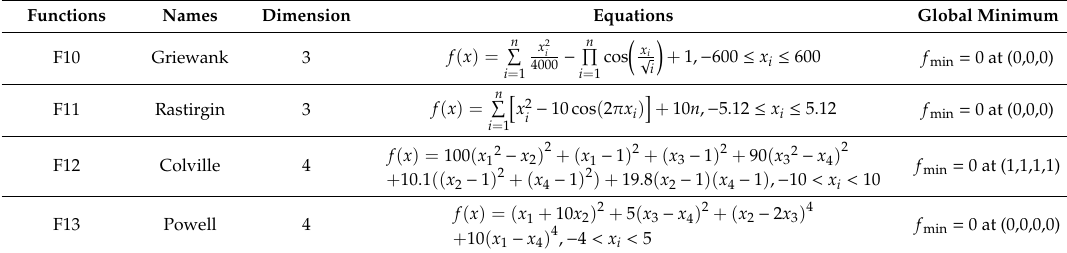
Table A3. High dimensional benchmark test functions considered in the simulations.